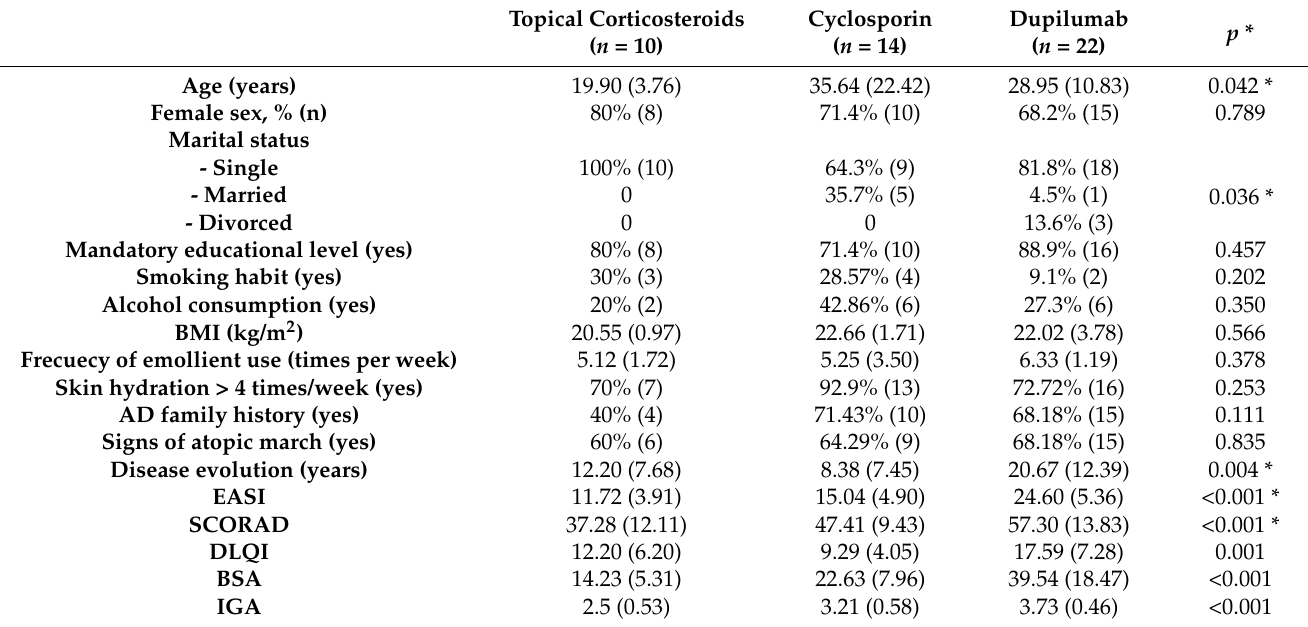
Table 1. Sociodemographic and clinical characteristics at